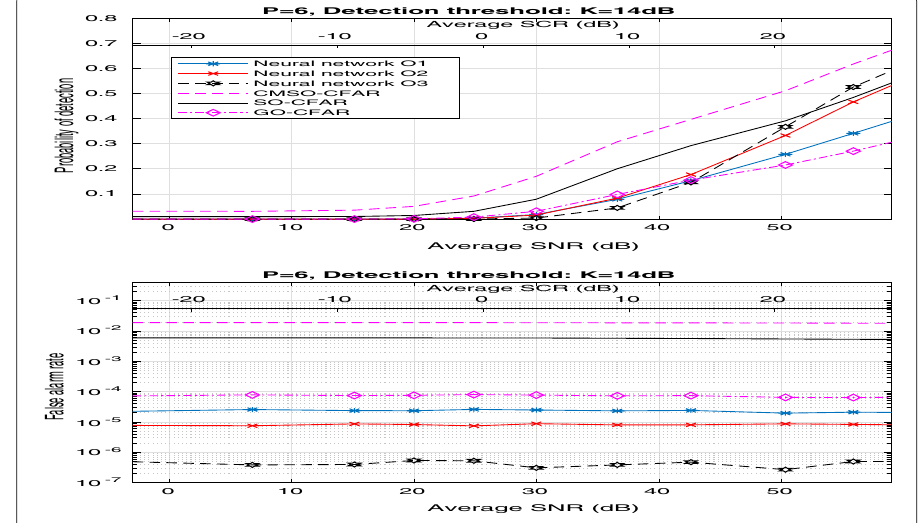
Fig. 10 P D and P FA , Clutter and noise scenario, 50 x 1 network, P = 6